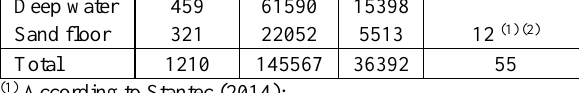
Table 2. Number of training areas with the corresponding area, the pixel count and the number of GPS